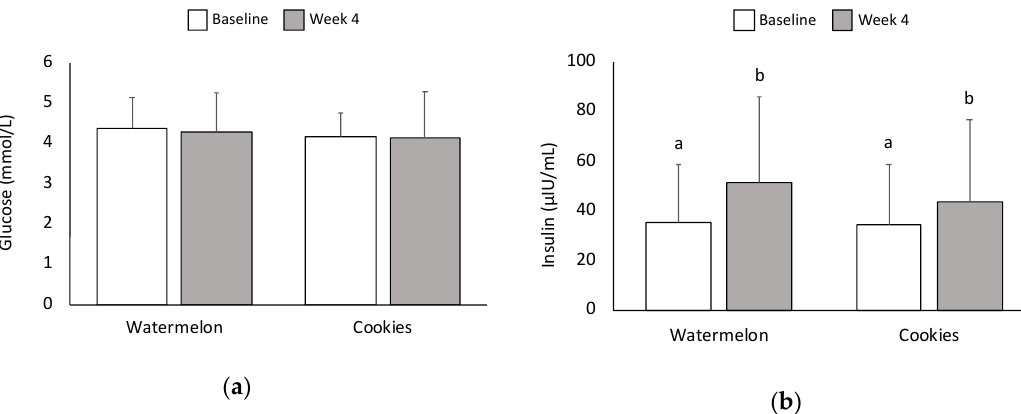
Figure 2. ( a ) Effects of WM and LFC on postprandial glucose. No significant differences in blood glucose were observed between snacks and between pre-consumption (pre) and 1-h postconsumption (post). ( b ) Effects of WM and LFC on postprandial insulin. Blood insulin significantly increased ( p < 0.05) in both snacks 1-h postconsumption compared with baseline. Data are presented as means ± SD. Within a variable, values not sharing common superscript are significantly different at p < 0.05.